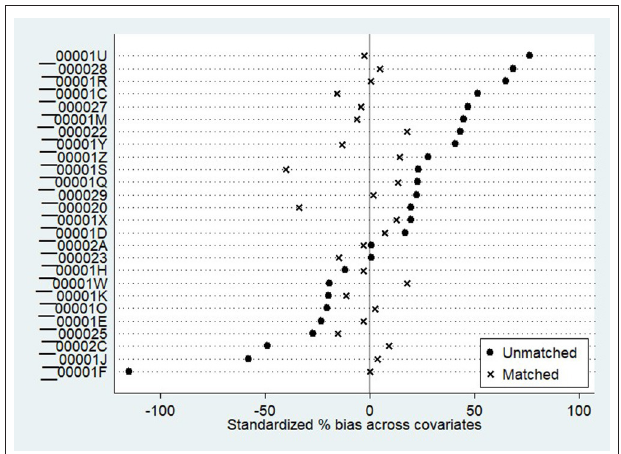
FIGURE 2 | The standardized bias across